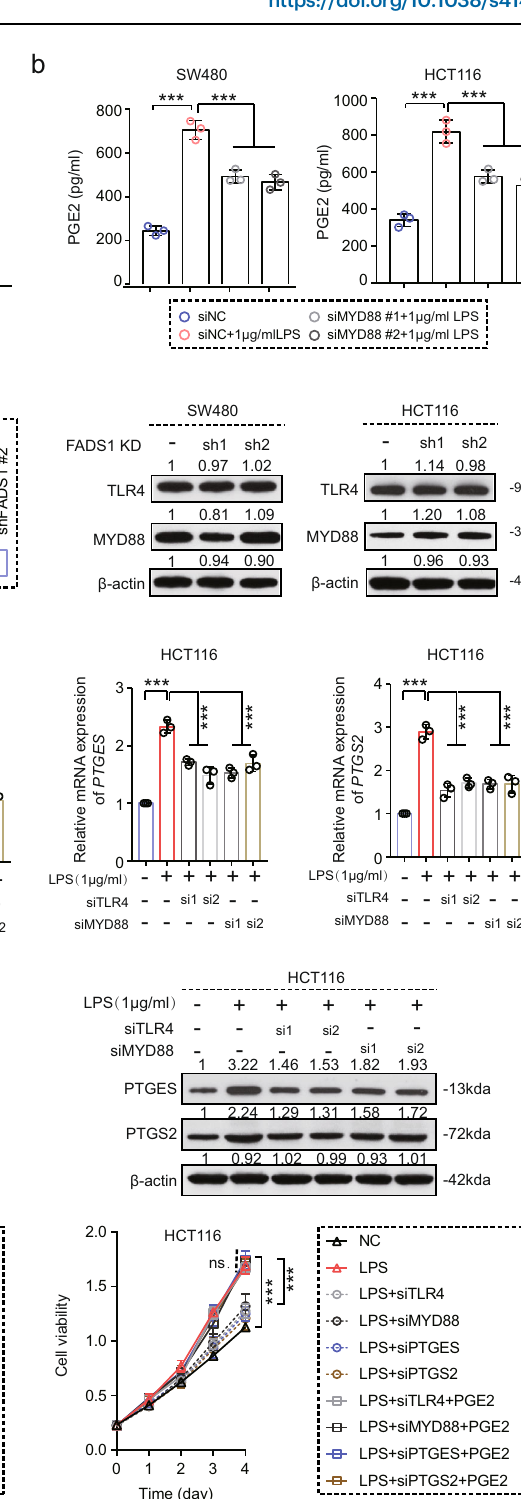
and HCT116 cells transfected with siTLR4 and siMYD88 , activated by 1 μ g/ml of LPS ( n =3pergroup,means±s.d.;two-tailedunpairedttest, n =3biologicalreplicates). *** p <0.001. e The protein expression of PTGES and PTGS2 in SW480 and HCT116 cells transfected with siTLR4 and siMYD8 8, activated by 1 μ g/ml of LPS. The grays- cale values of the WB bands are quantitatively represented ( n =3 biological repli- cates). f Viability of SW480 and HCT116 cells transfected with siTLR4 , siMYD88 , siPTGES , siPTGS2 andsiNC,activatedby1 μ g/mlofLPS,rescuedbyadding1mg/Lof PGE2 ( n =5 samples per group; means ± s.d., one-way repeated-measures ANOVA, n =3 biological replicates). *** p <0.001, ns indicates no statistical signi fi cance. Source data are provided in the Source Data fi